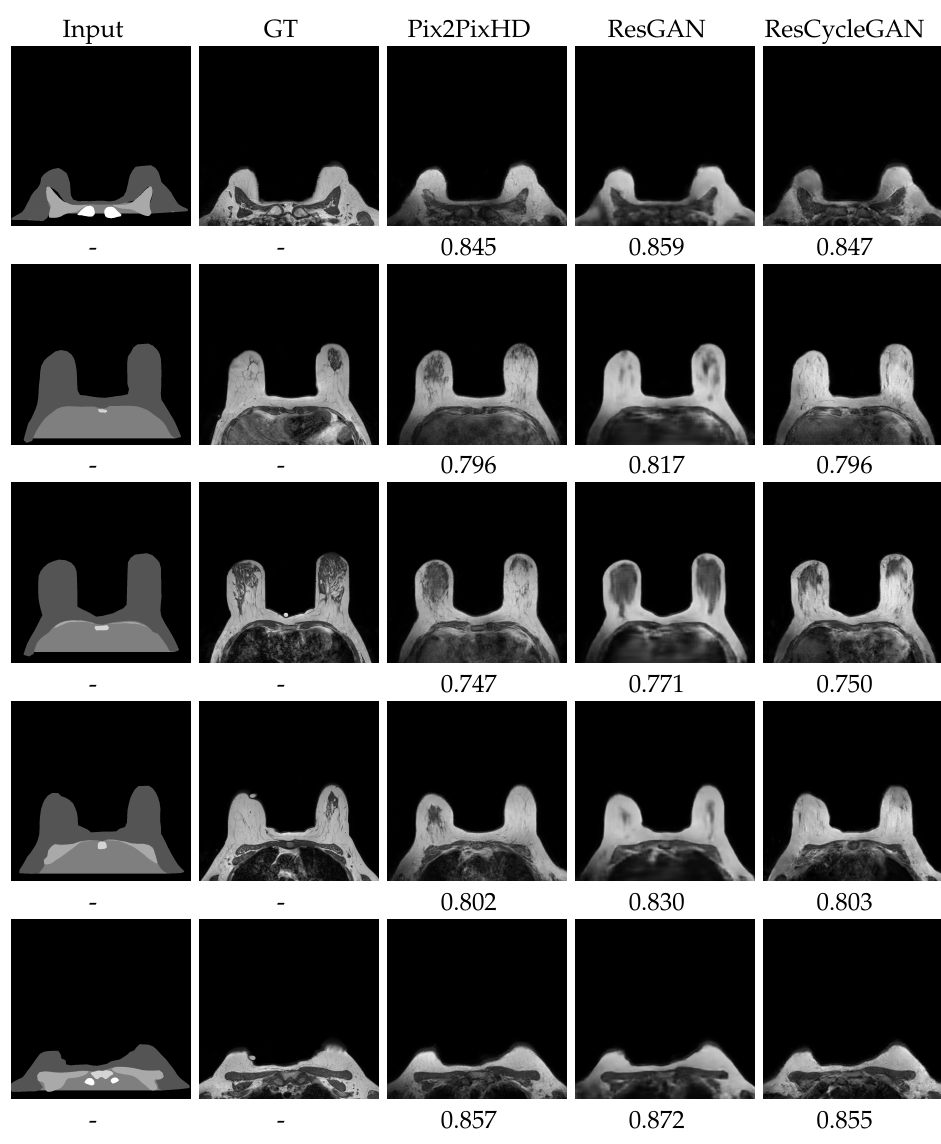
Figure A2. Further best visual test set generation results and respective SSIM. ResGAN and Pix2Pix- HD with BS8. CycleGAN with BS1 and Experience Replay. Part